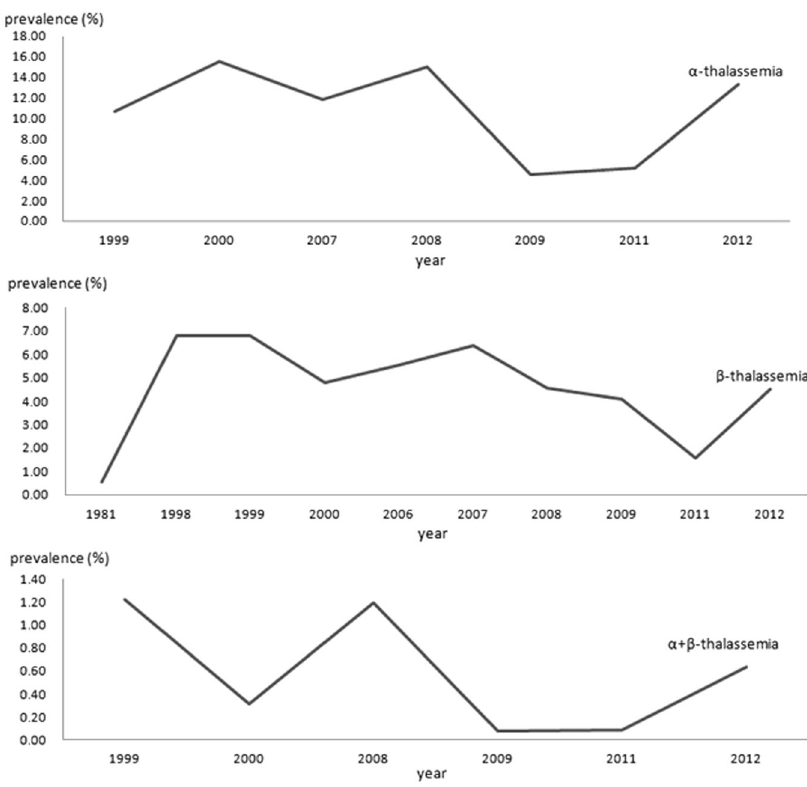
Figure 3. Analysis of the thalassemia prevalence by year.